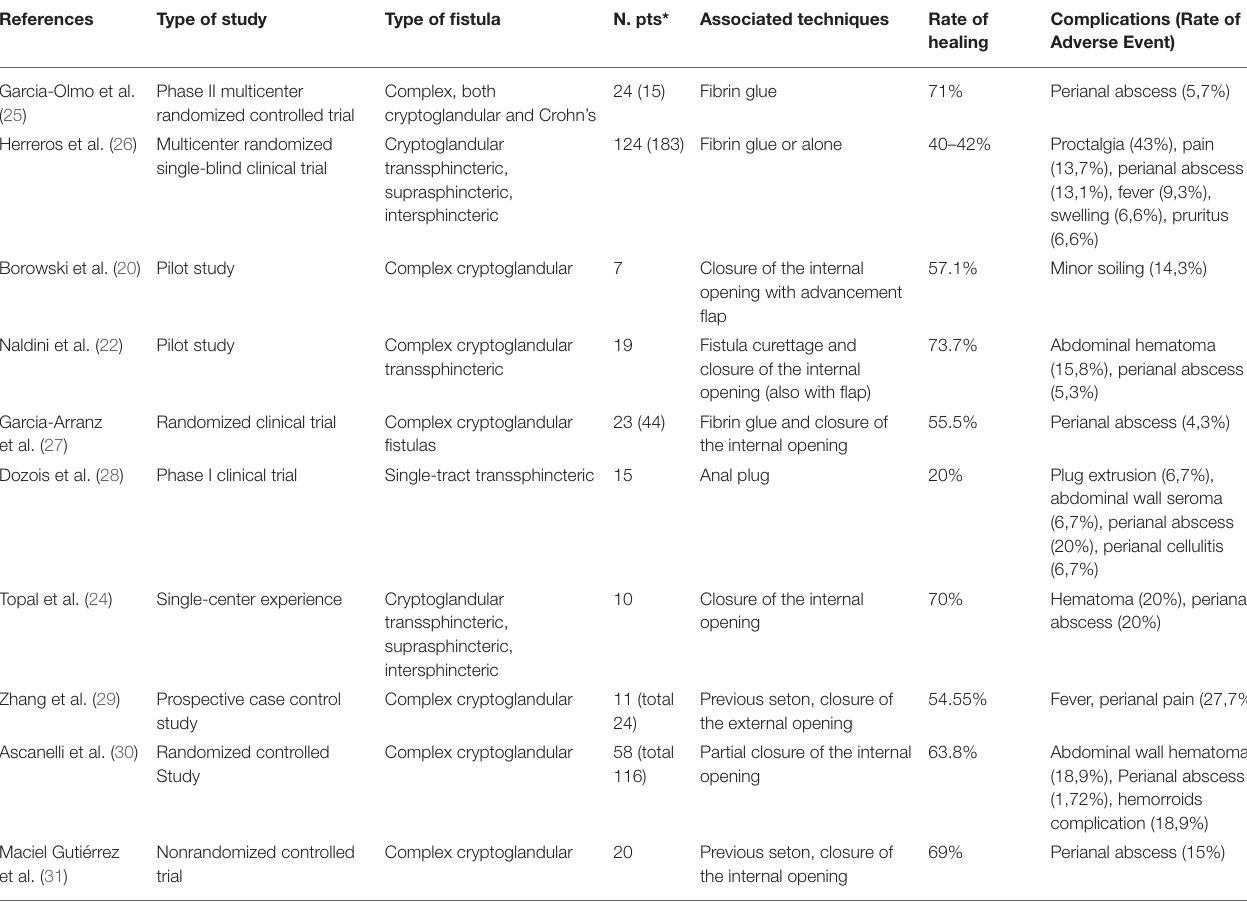
TABLE 1 | Mesenchymal stem cells for cryptoglandular anal fistula: clinical